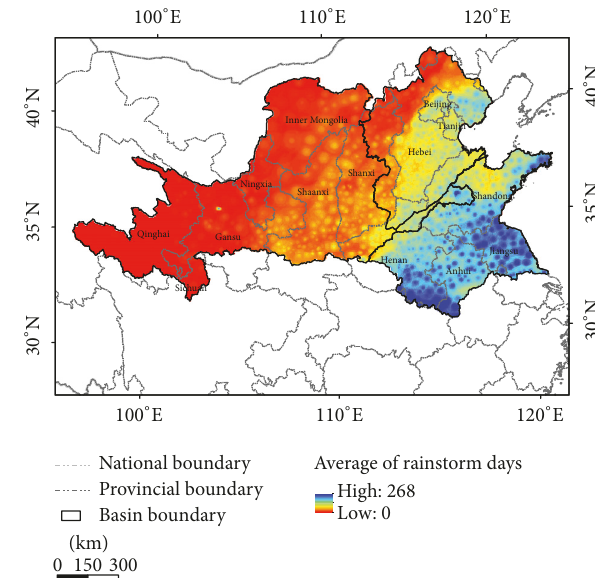
Figure 19: The spatial distribution of multiyear average WYC from 1982 to 2011.